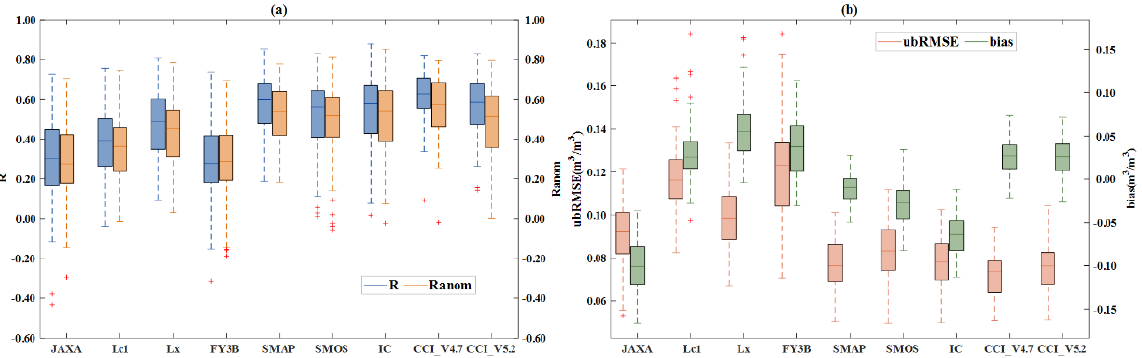
Figure 2. Boxplots of ( a ) R and Ranom, ( b ) ubRMSE, and bias against ISMN observations only considering the common data points of all products from 2016 to 2018.